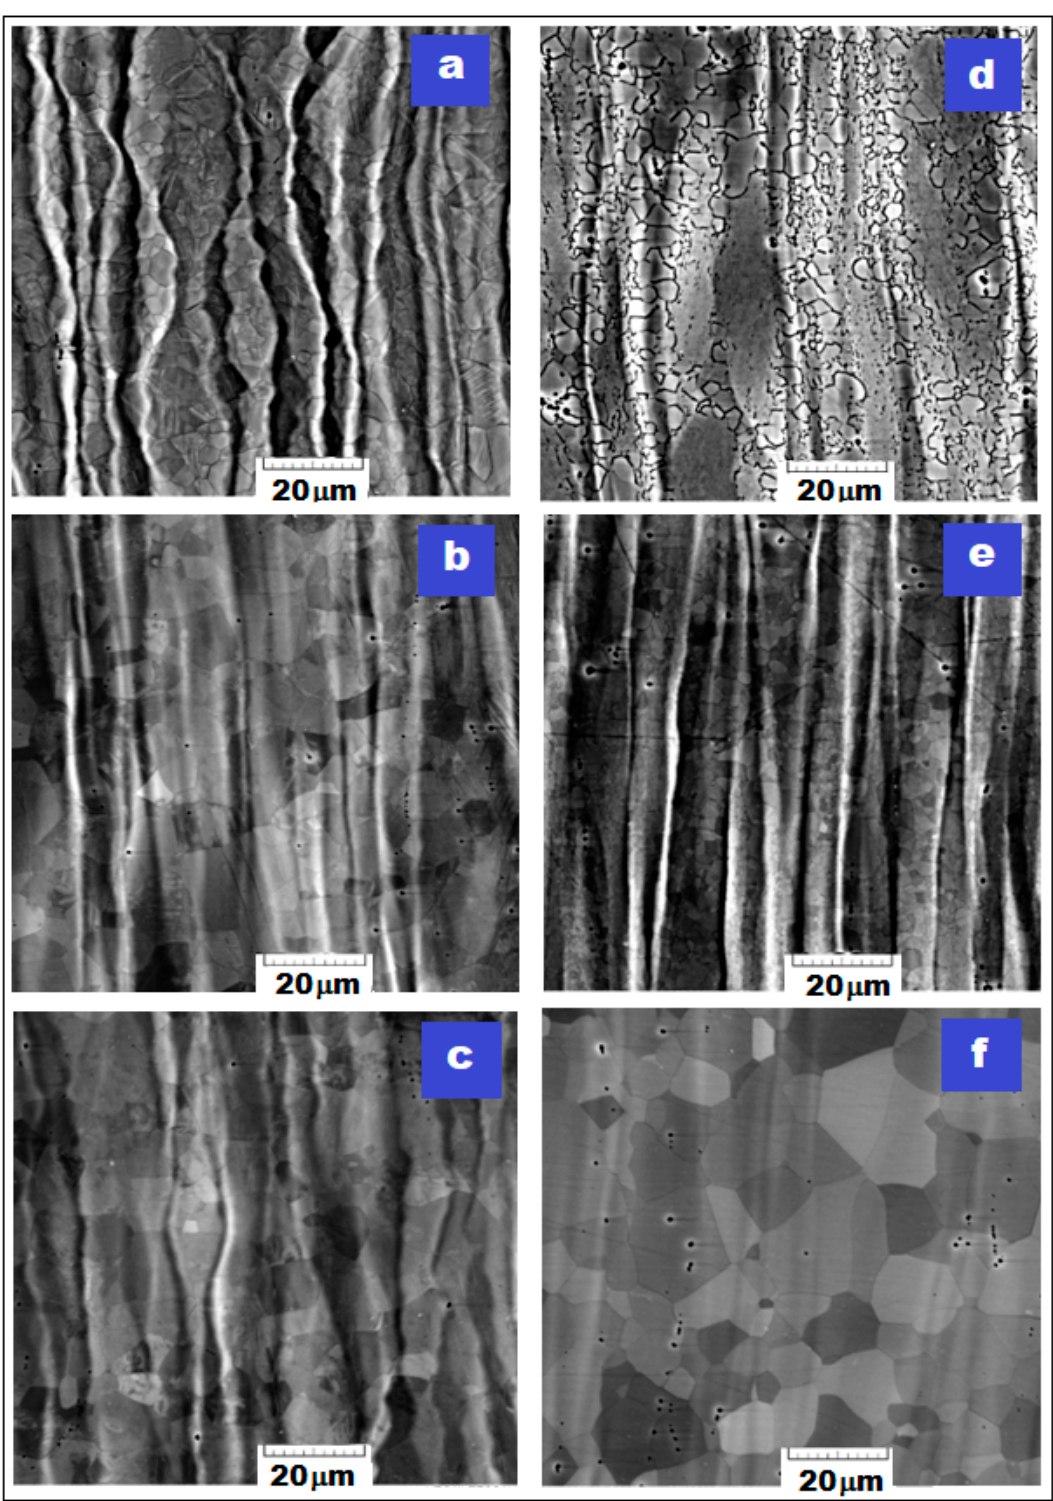
Figure 5. XRD patterns of the Ti29Nb-9Ta-10Zr alloy corresponding to the following stages: ( a ) MPR (90%) + R1 (780 °C/5 min/w.q.); ( b ) MPR (90%) + R2 (830 °C/5 min/w.q.); ( c ) MPR (90%) + R3 (880 °C/5 min/w.q.); ( d ) MPR (90%) + R1 + A (400 °C/5 min/w.q.); ( e ) MPR (90%) + R2 + A (400 °C/5 min/w.q.); ( f ) MPR (90%) + R3 + A (400 °C/5 min/w.q.).